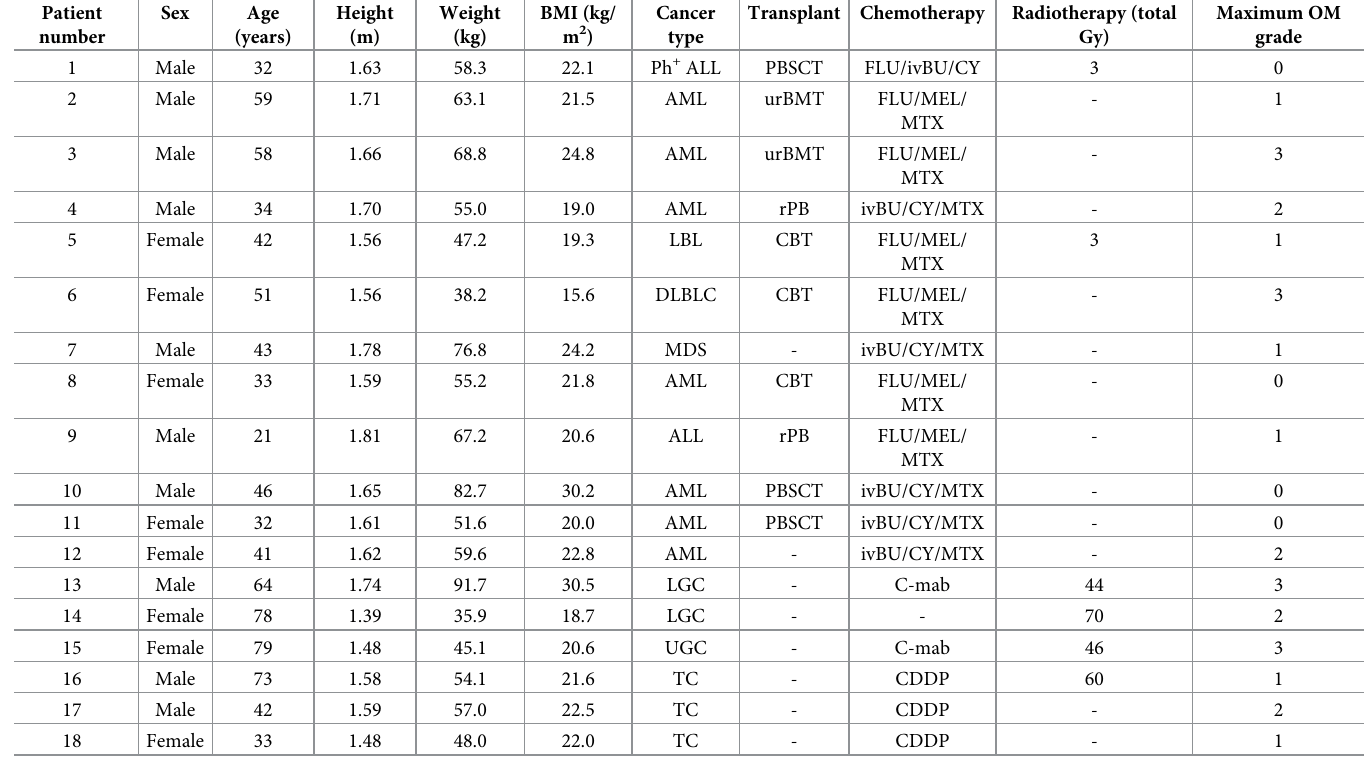
Table 1. Patient